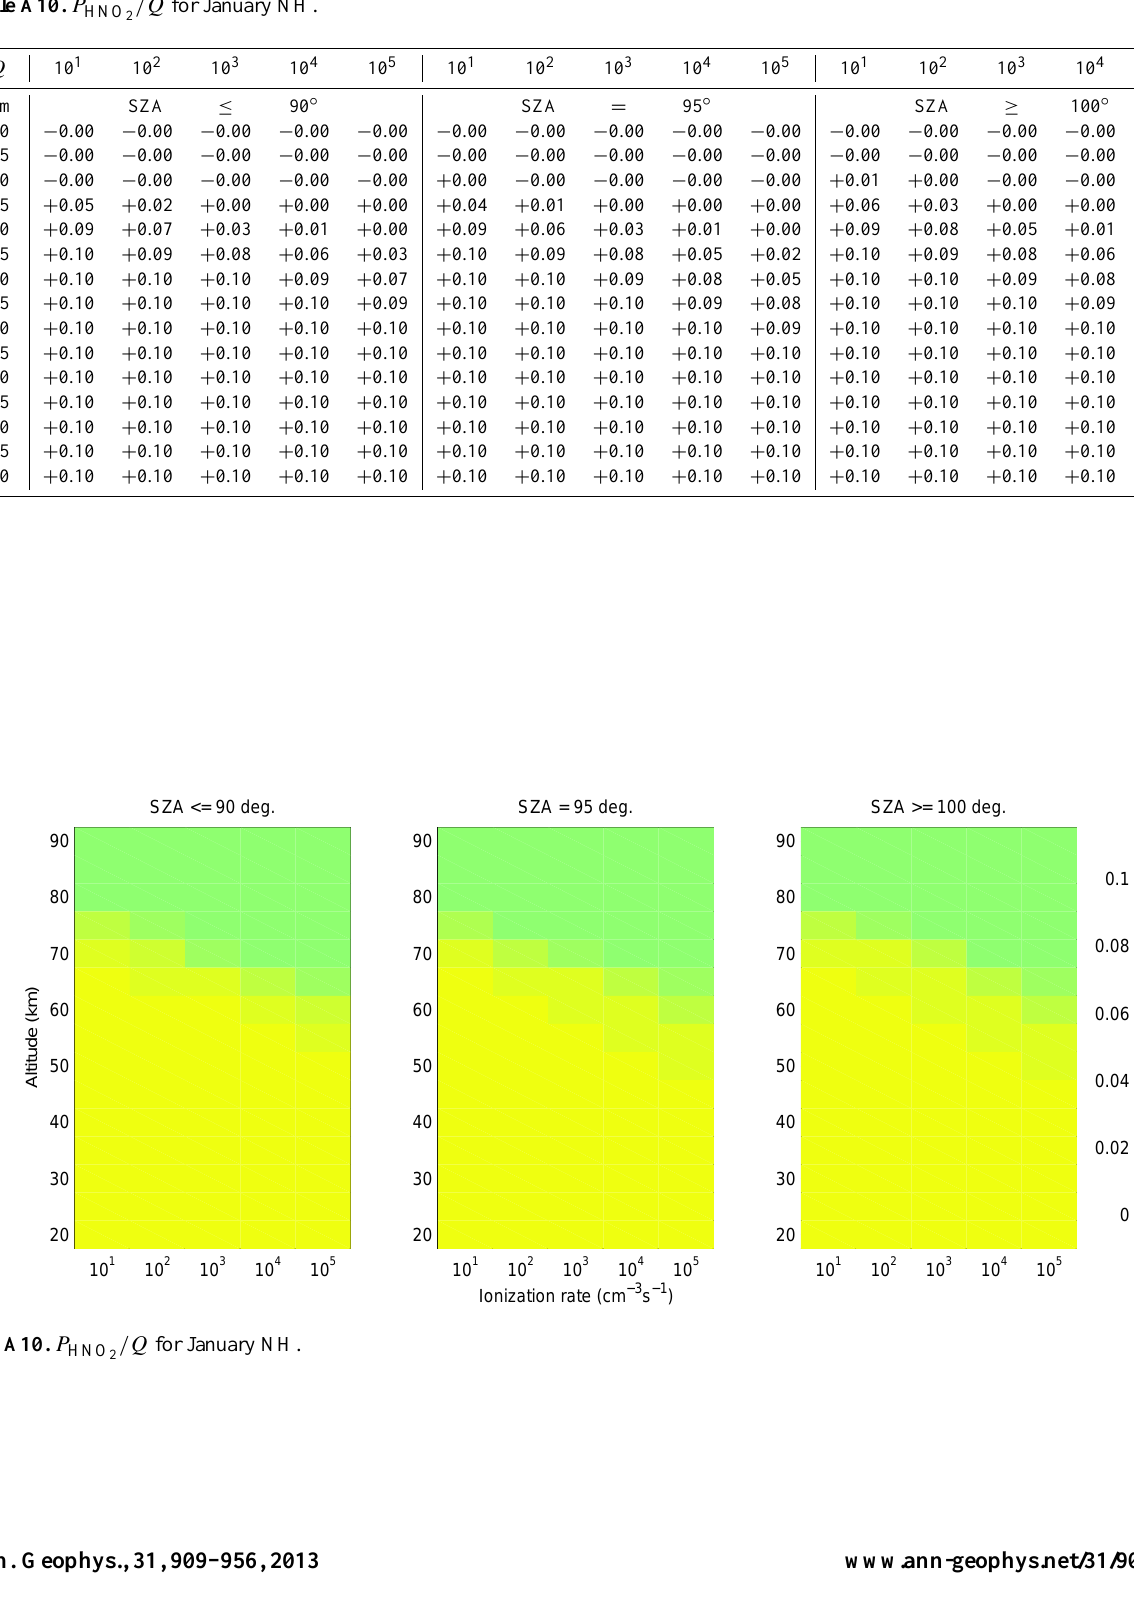
Table A10. P HNO